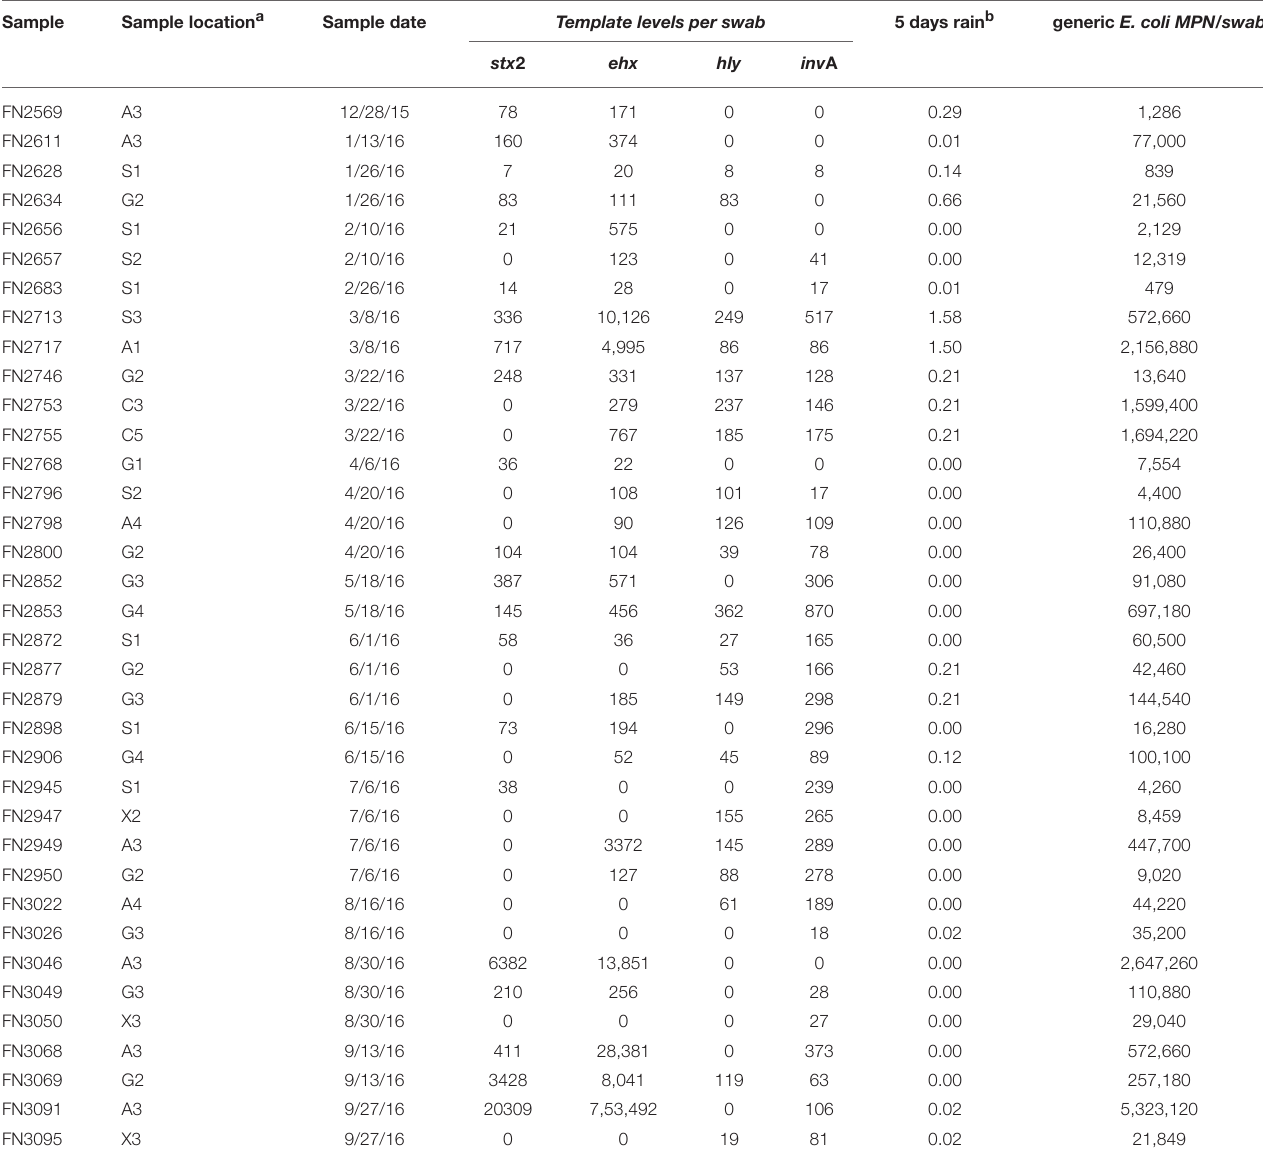
TABLE 6 | ddPCR quantification in individual Moore